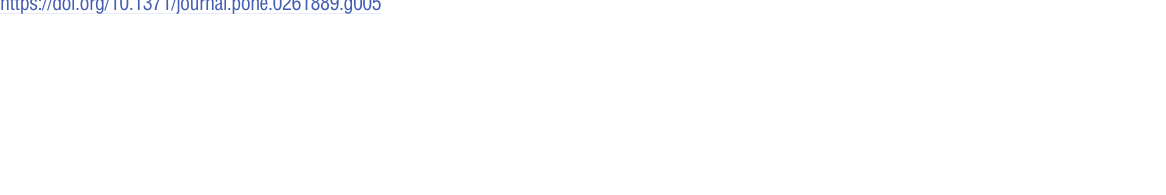
PLOS ONE | https://doi.org/10.1371/journal.pone.0261889 December29,